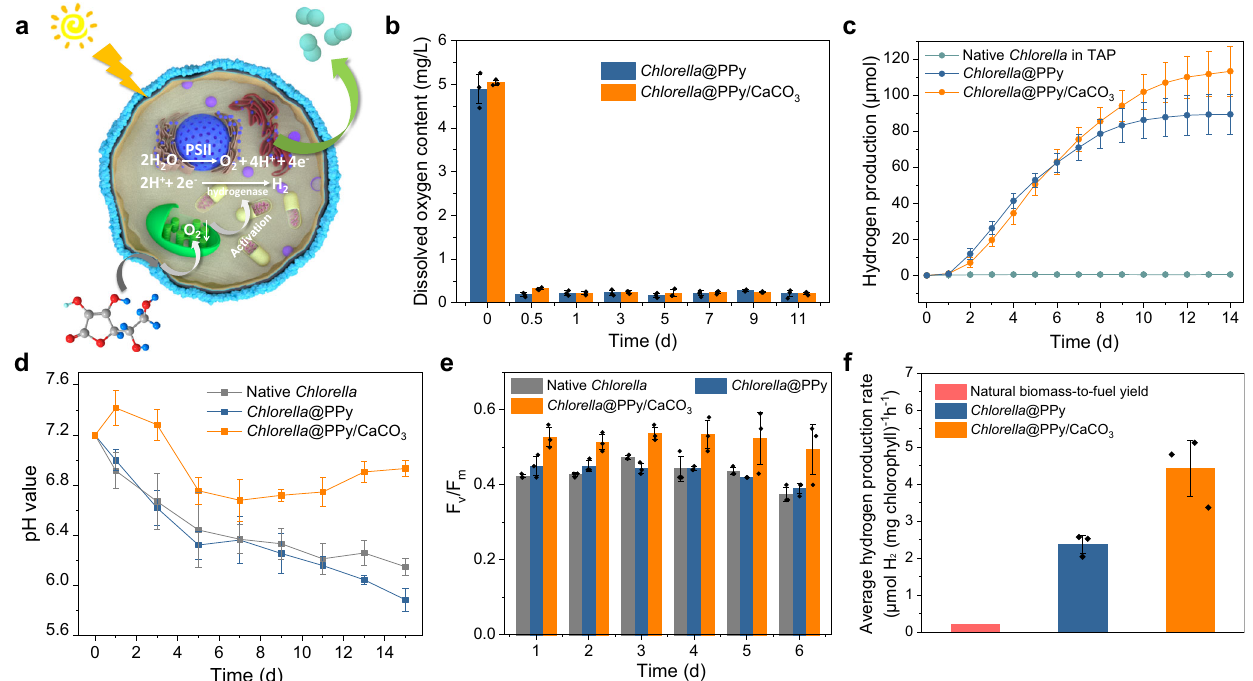
Fig. 2 | Hypoxic photosynthetic hydrogen production in surface-augmented algal cells. a Schematic illustration of photosynthesis in PPy/CaCO 3 -coated Chlorella cells.Hypoxicconditionsaregeneratedbydepletionofoxygenlevelsdue to Fe(III)/PPy-mediated oxidation of ascorbate (shown as molecular graphic) pre- sent in the external environment, giving rise to hydrogenase activation and hydrogen production (paired cyan circles). The decrease of pH arises from the oxidation of added ascorbate and is buffered by the CaCO 3 shell, which also facil- itates prolonged hydrogenase activity. b – e Time-dependent measurements of dissolved oxygen concentration ( b ), hydrogen production ( c ), pH ( d ) and photo- synthetic activity ( F v /F m ) ( e ) in anascorbate-containing TAP culture medium in the presence of native, PPy-coated or PPy/CaCO 3 -coated Chlorella cells. Data are pre- sented as mean values±SD, error bars indicate standard deviations ( n =3,